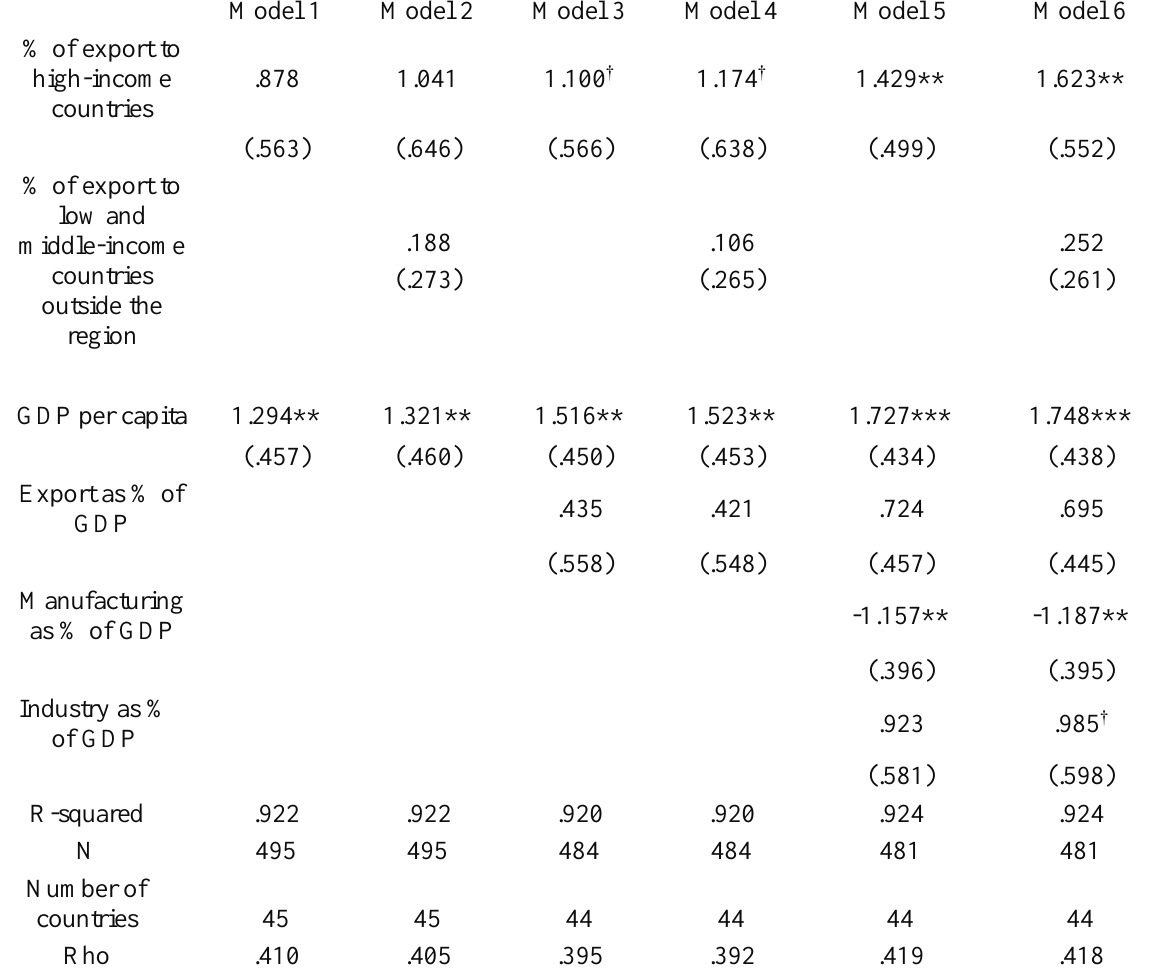
Table 6. Regression of Plastic Waste Import Trade Value, 2003-2013, Two-Way Fixed Effects PW Regression Model Estimates for 45 High-Income